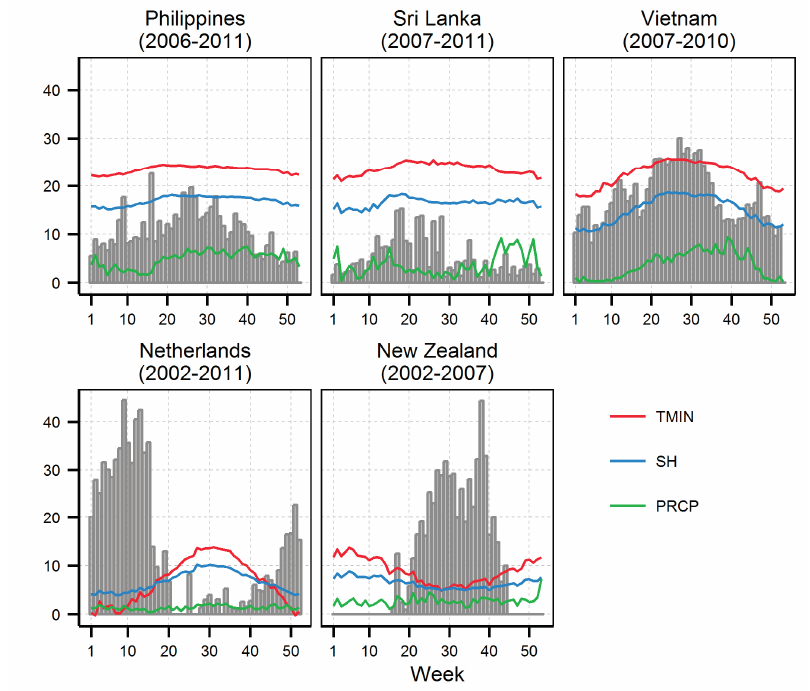
Figure 3. Weekly influenza positive (in %) and meteorological parameters averaged across study period. Bar plot shows the percentage of influenza positive. TMIN is